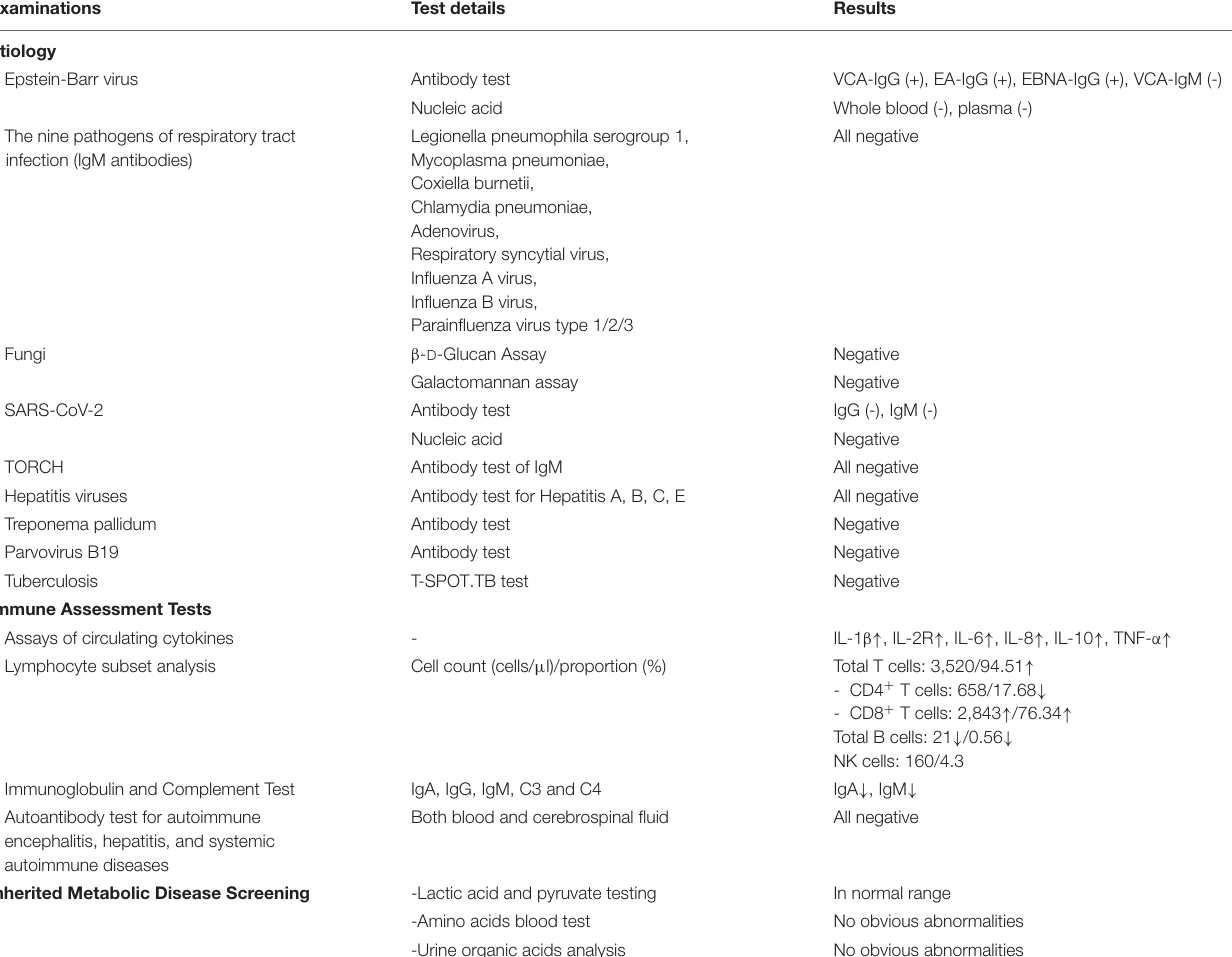
TABLE 2 | Further laboratory examinations of the